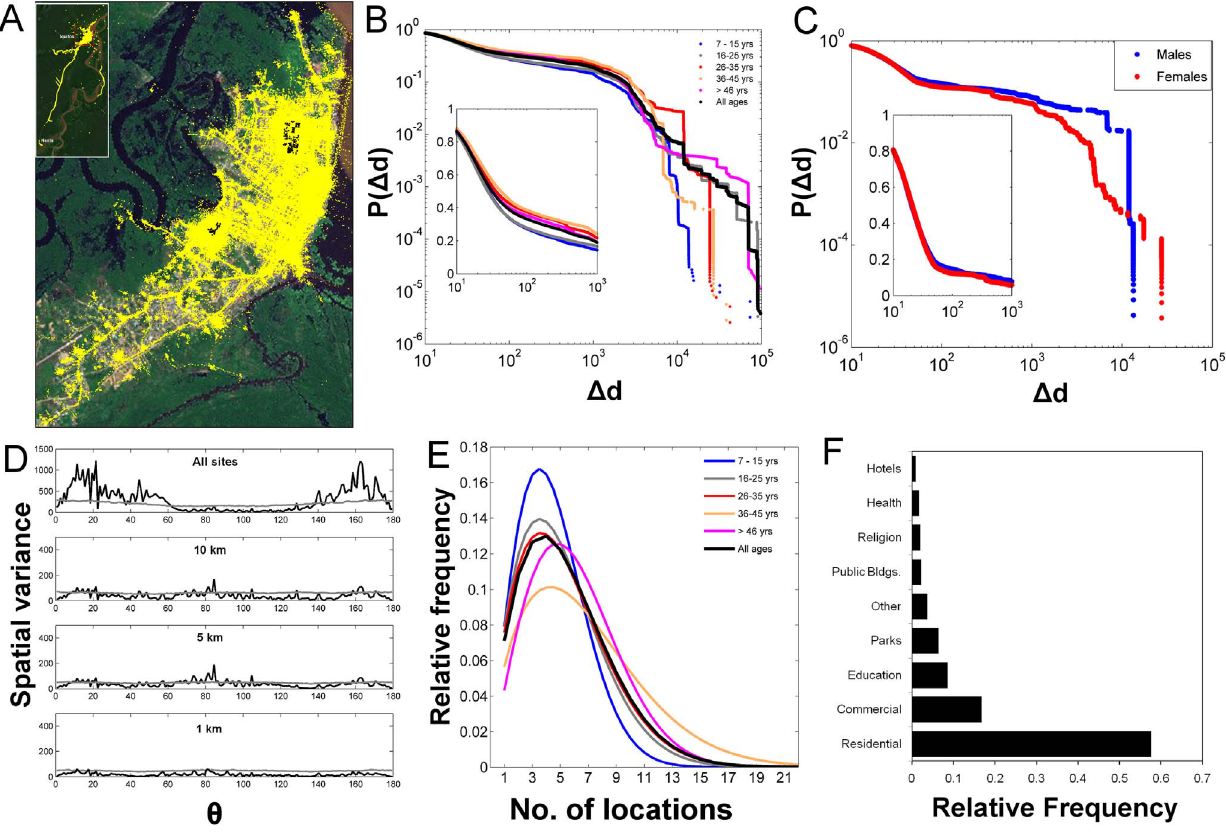
Figure 1. Mobility parameters inferred from GPS data-logger data. (A) Raw GPS locations ( , 2.3 million points) obtained from tracking the movements of 582 individuals. Map inset shows out-of-city movements. (B) Human movement kernels (probability of movement outside an individual’s home ( P( D d) ) for all individuals and for different age groups. Inset in frame B shows the probability of movement within 1 km from an individual’s home. (C) P( D d) for males and females. (D) Spatial wavelet variance (black line) as a function of the angle from a person’s home ( h ). Anisotropy is detected when variance is higher than the randomness expectation (grey line). (E) The probability distribution of the number of places an individual routinely visited. (F) The relative frequency of visitation across type of